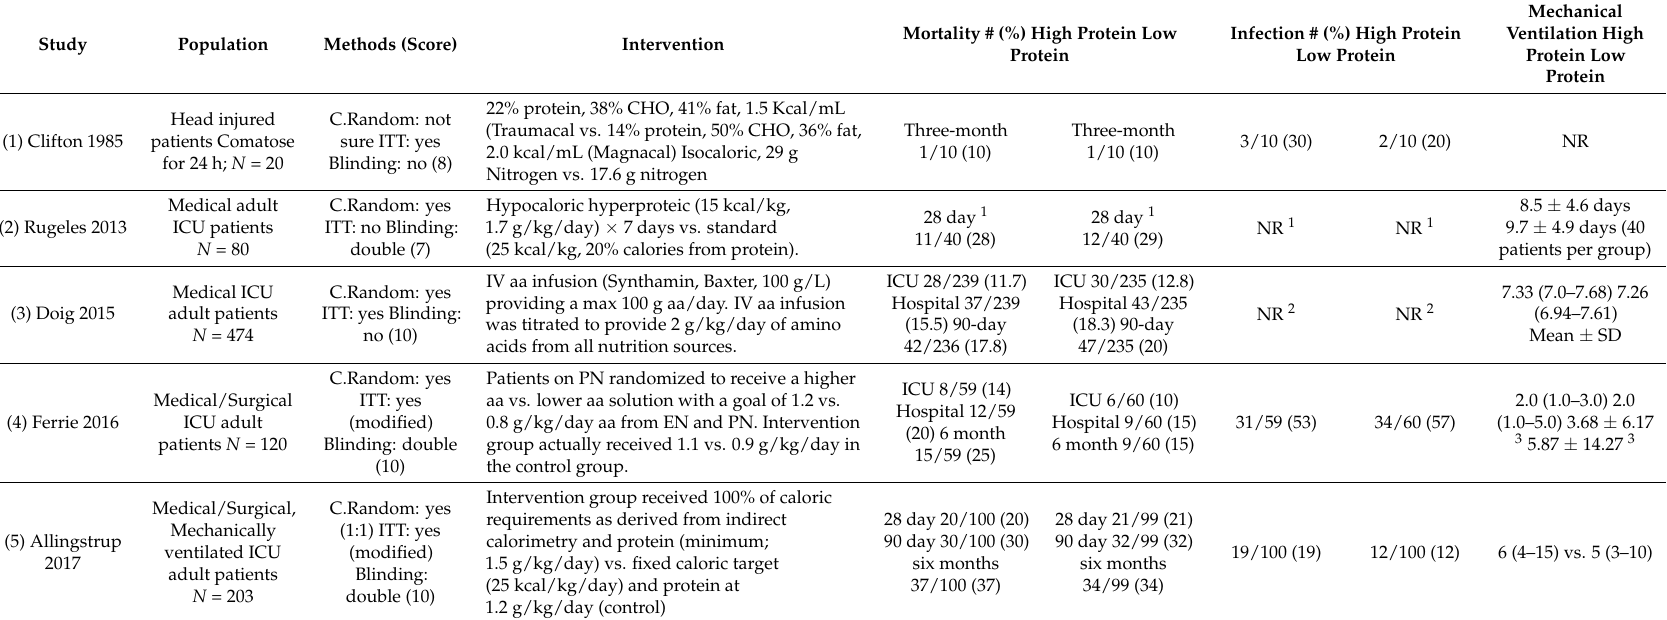
Table 1. Randomized trials of high vs. low protein/amino acid